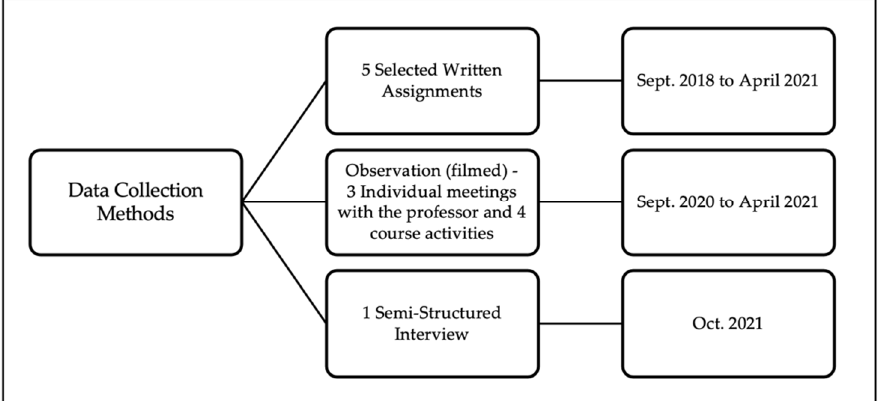
Figure 2. Data Collection